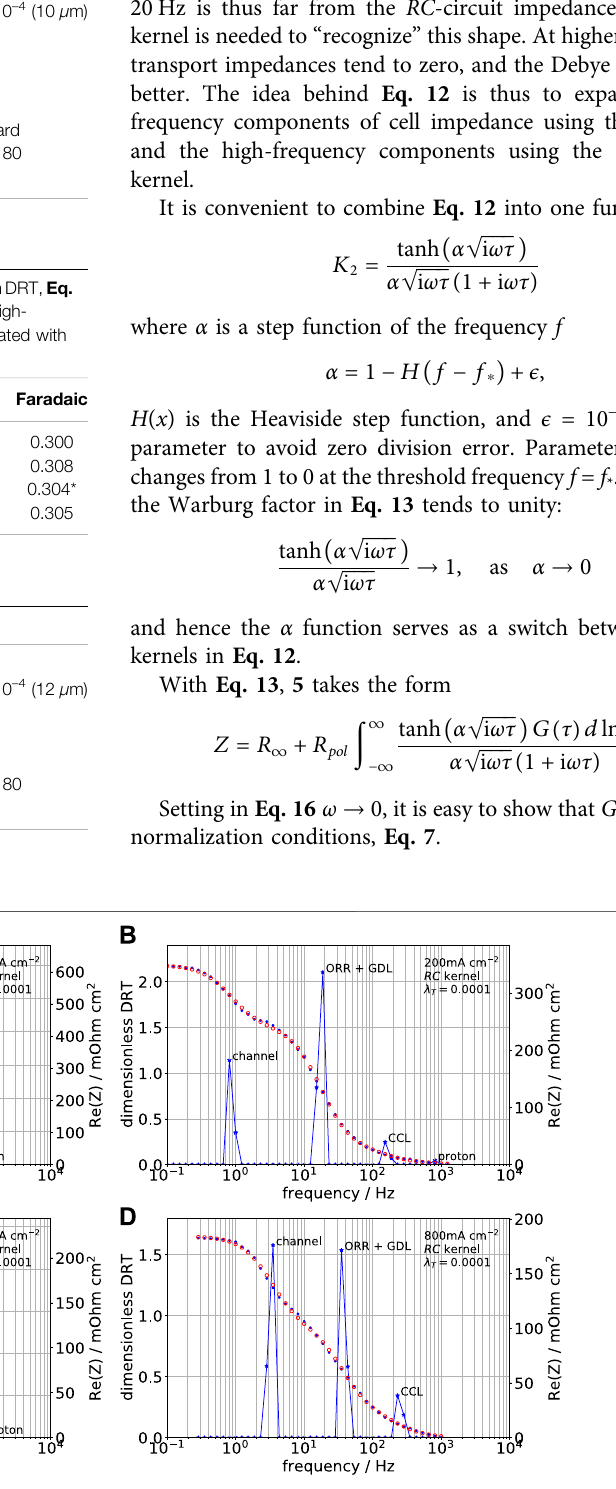
FIGURE 5 | DRT (solid line, left axis) calculated with the RC kernel using real part of the experimental PEMFC impedance (blue dots, right axis) for the current densities (A) 100, (B) 200, (C) 400, and (D) 800 mA cm − 2 . Red open circles — Re ( Z ) reconstructed from the calculated DRT.